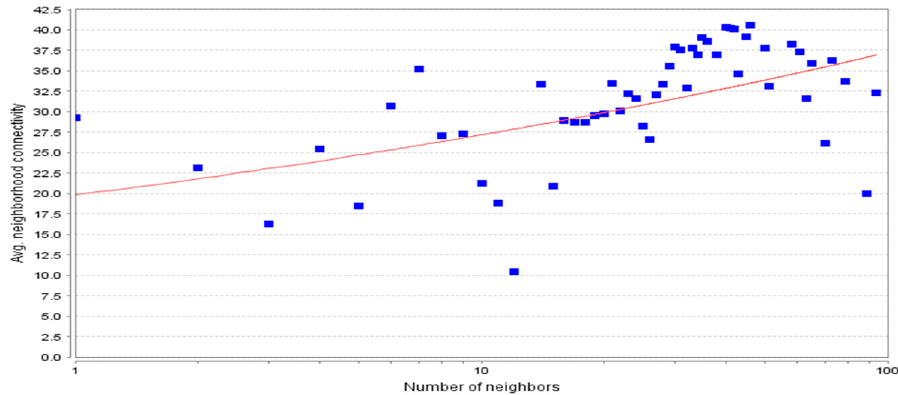
Figure 6. Average (Avg.) neighborhood connectivity distribution following power law fitting y = 19,838x 0.137 (R-squared 0.253). The average number of neighbors is 15,940.